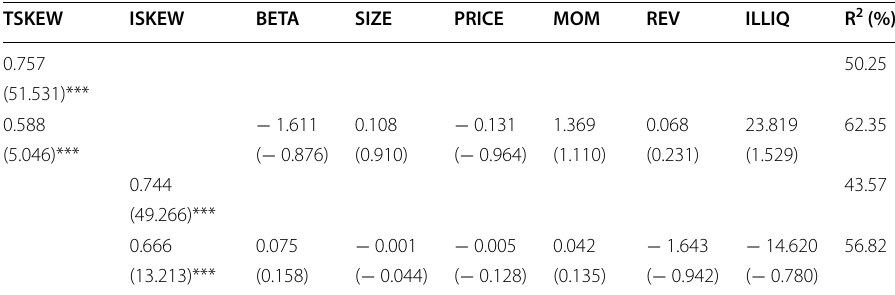
Table 13 Cross-sectional predictability of skewness